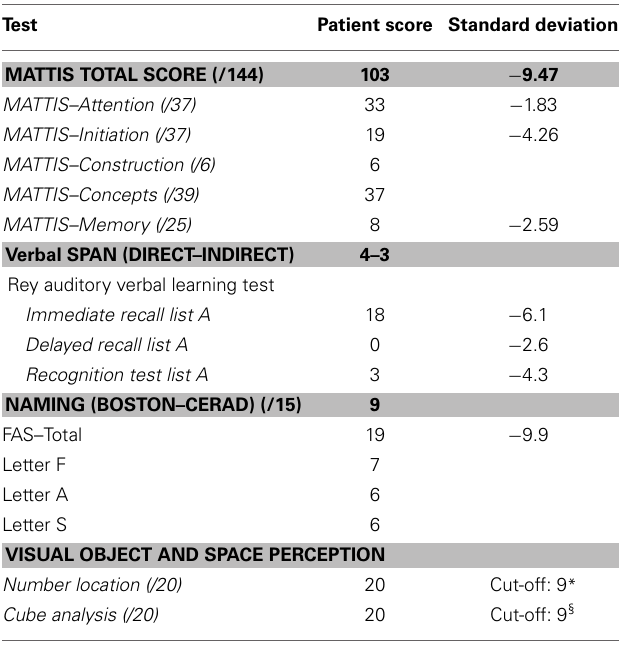
Table 3 | Neuropsychological assessment of the patient YCFZ (November 2010).